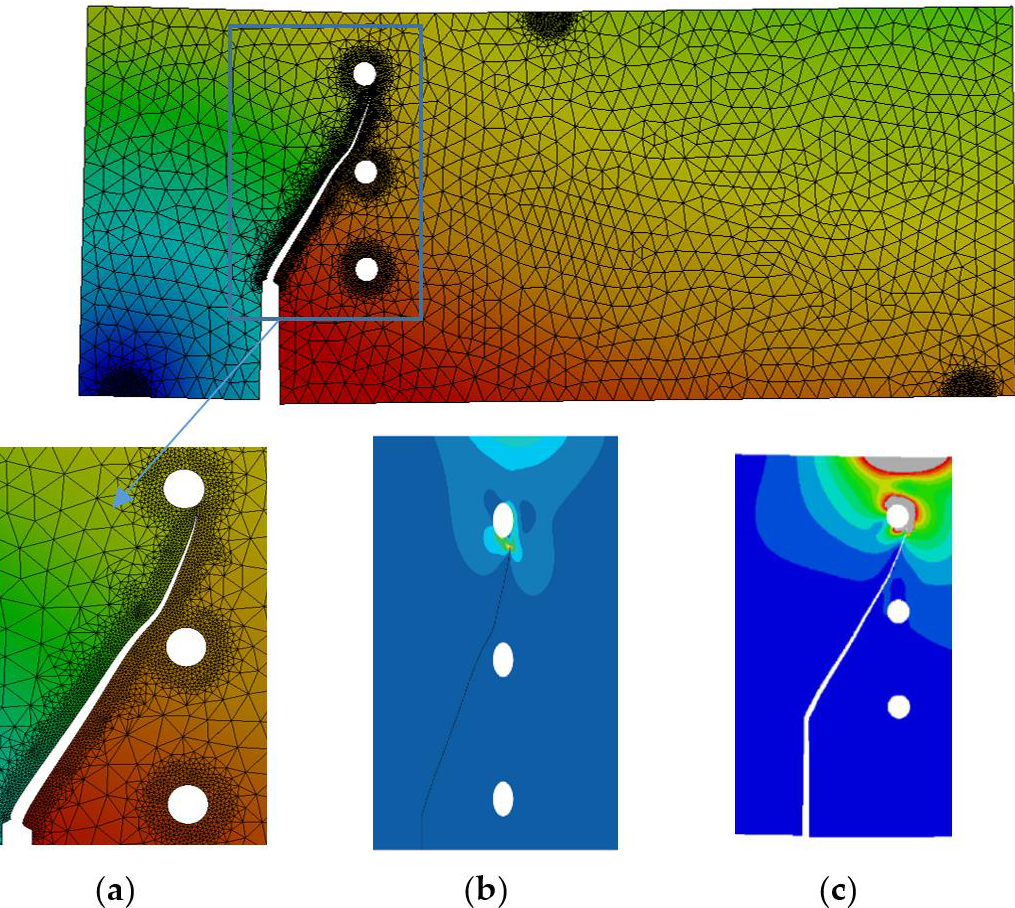
Figure 15. Final step of the crack growth trajectory for specimen 5, ( a ) Present study, ( b ) numerical results [50], ( c ) numerical results [36].